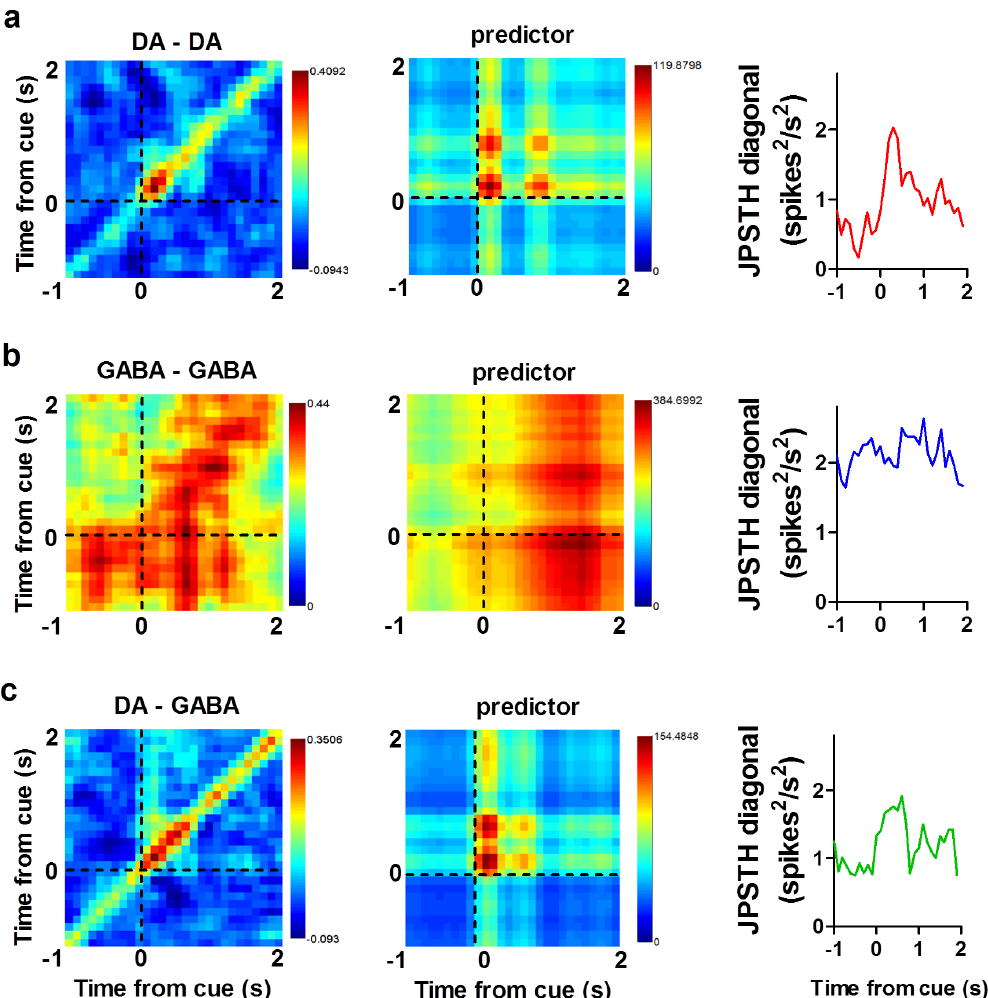
Figure 4. Synchrony is enhanced immediately after the reward cue. Examples of synchrony between pairs of SN neurons following the reward cue. ( a ) Example of a corrected joint peri-stimulus time histograms (JPSTH) in the left column, corresponding predictor matrix (middle) and histogram of JPSTH diagonal (right; 500 ms width) for a pair of simultaneously recorded DA neurons ( a ), GABA neurons ( b ), and DA-GABA pairs ( c ); DA activity is plotted on the horizontal axis. Axes are time relative to the reward cue. The predictor matrix is subtracted bin-by-bin from the raw JPSTH, and then normalized by the standard deviation of the predictor matrix (100 ms 6 100 ms bins).